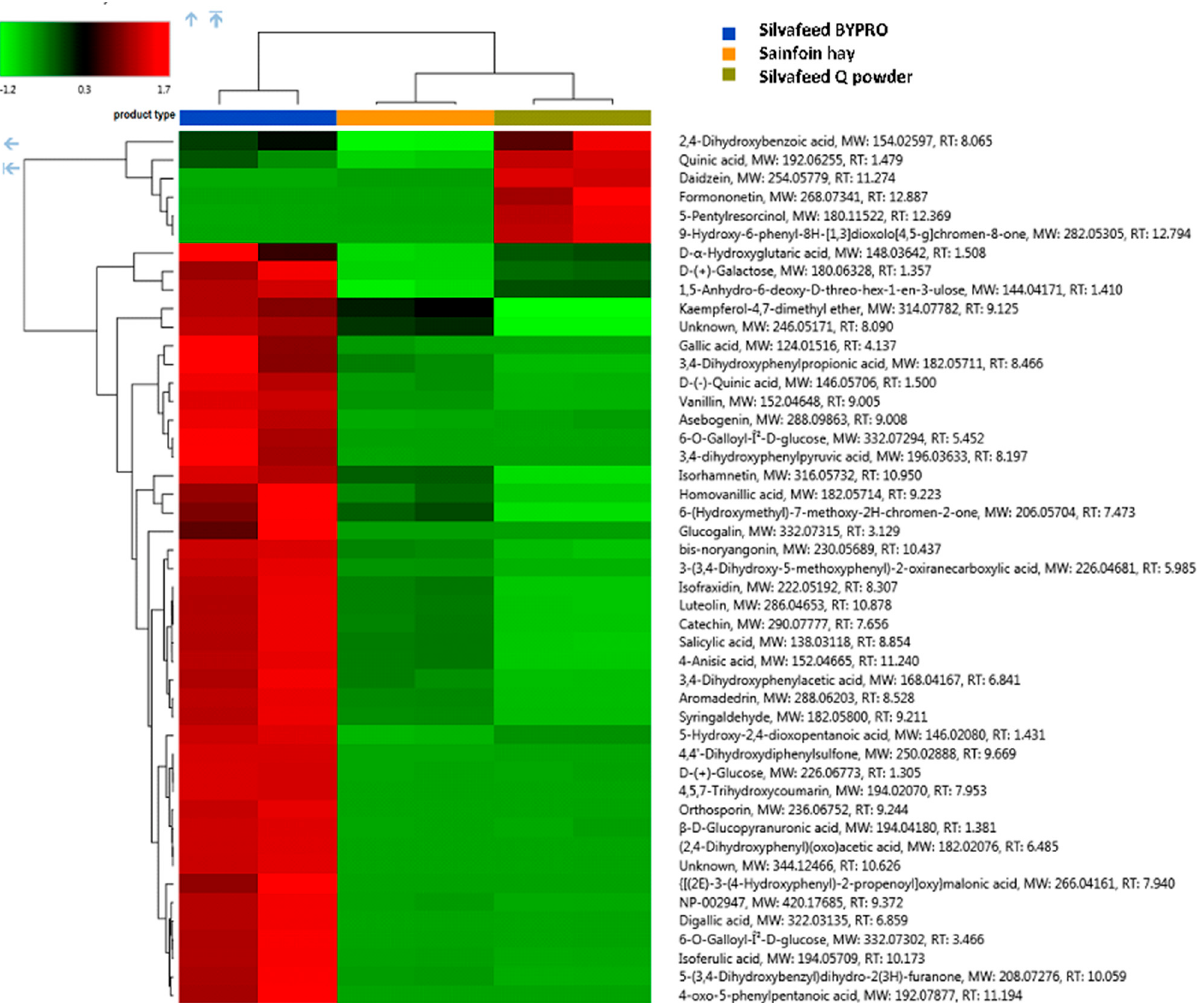
Figure 1. Hierarchical cluster analysis for the 45 most abundant species of flavonoids identified in ethanol extracts. Heatmap reflects the differences between the relative amount through normalized chromatographic peak areas in respect to sample type; z-color scale indicates normalized peak area value: red and green indicates more and less abundant, respectively.